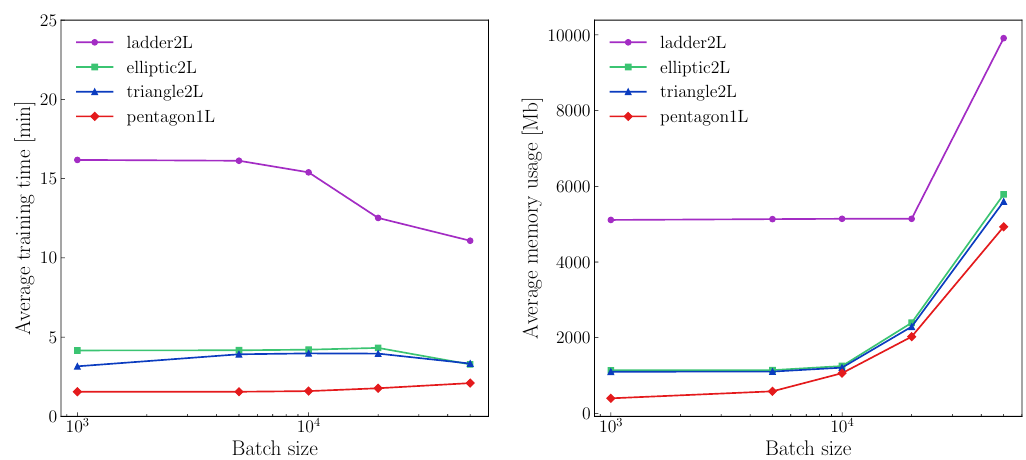
Figure 7: Average training times (left) and average memory consumption (right) for a single phase-space point as a function of the batch size b